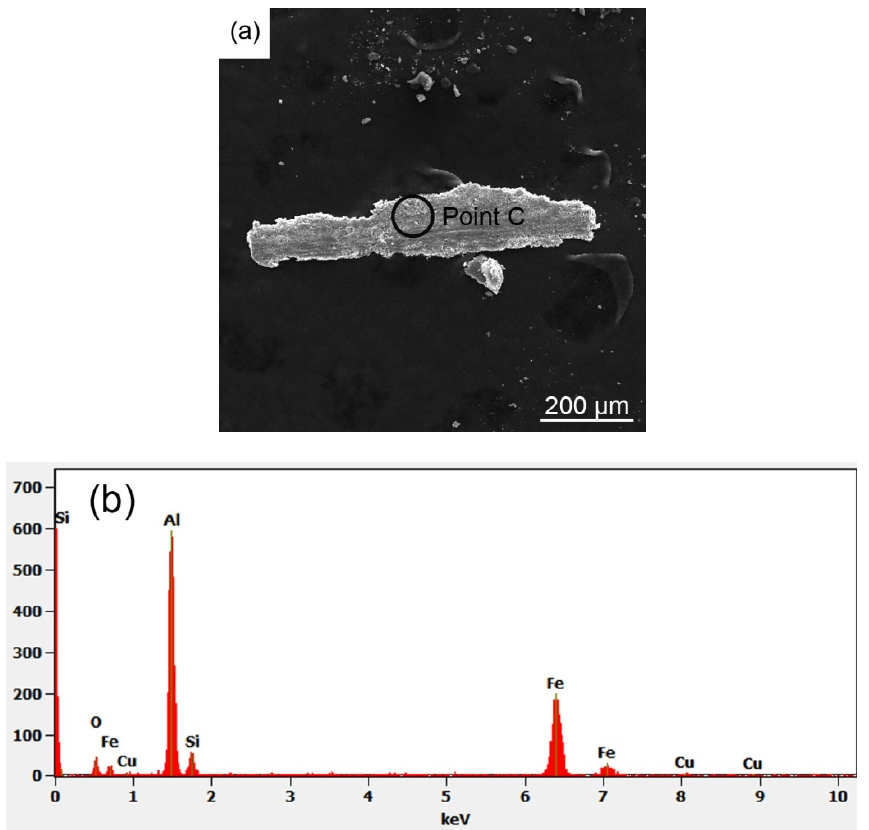
Table 4. EDS results of area A, area B and point C (wt %).